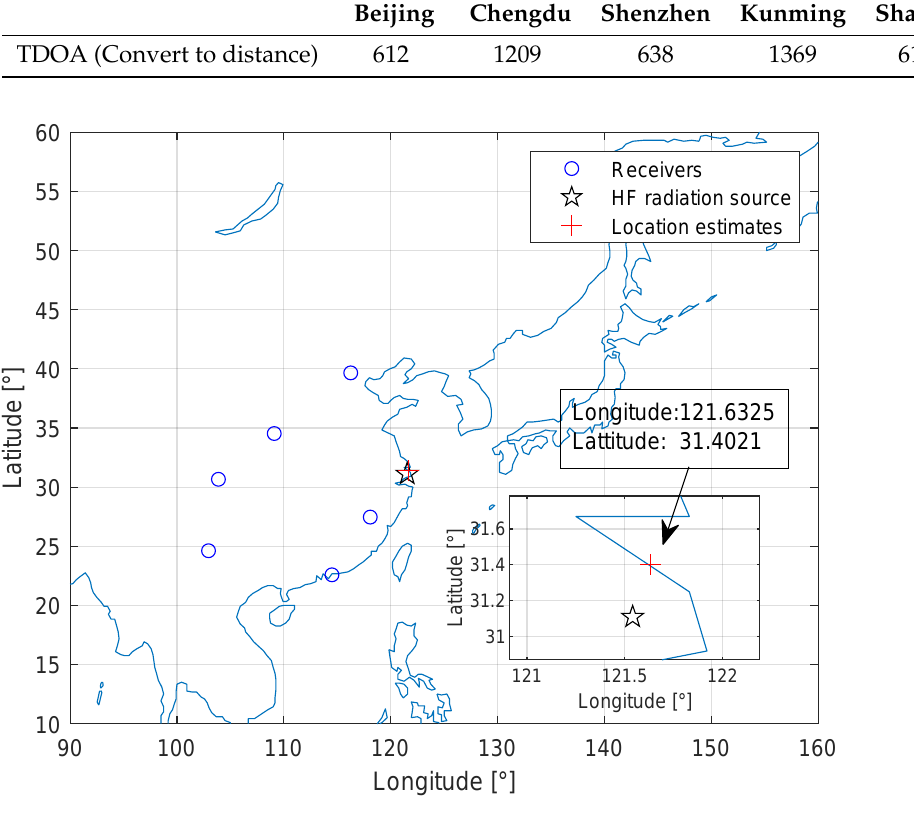
Figure 11. Experimental results of Shanghai HF source geolocation